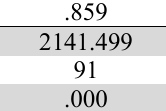
KMO and Bartlett's Test Kaiser-Meyer-Olkin Measure of Sampling Adequacy,